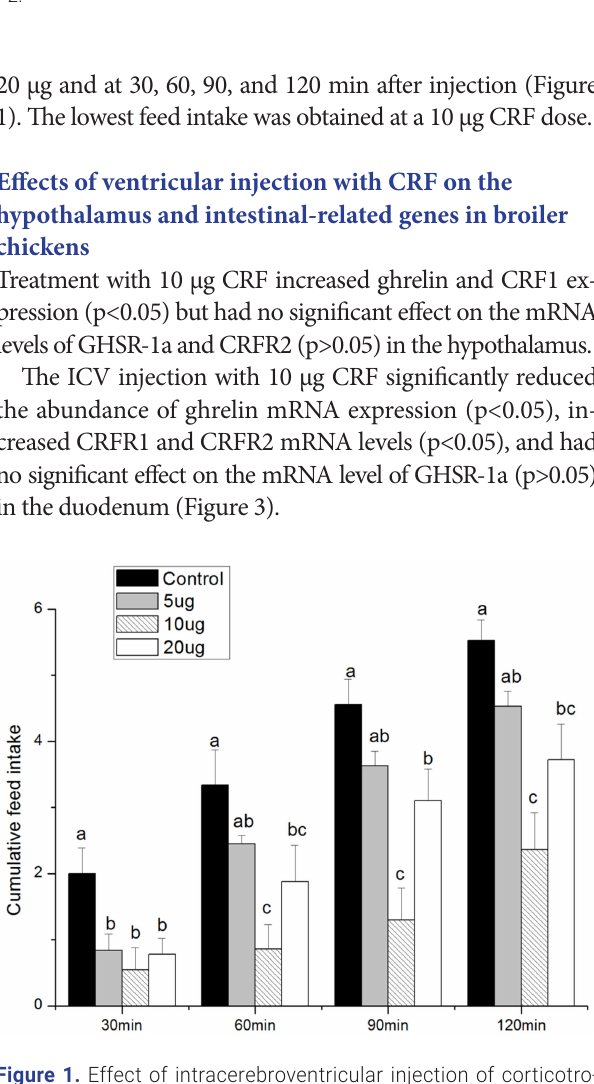
Figure 1. Effect of intracerebroventricular injection of corticotropin-releasing factor (CRF) on accumulative broiler feed intake within 2 h post-injection. Control = control group (basal diet); 5 μg = 5 μg/kg body weight; 10 μg = 10 μg/kg body weight; 20 μg = 20 μg/kg body weight; a-c Values with different letters differ significantly (p<0.05); n = 8.